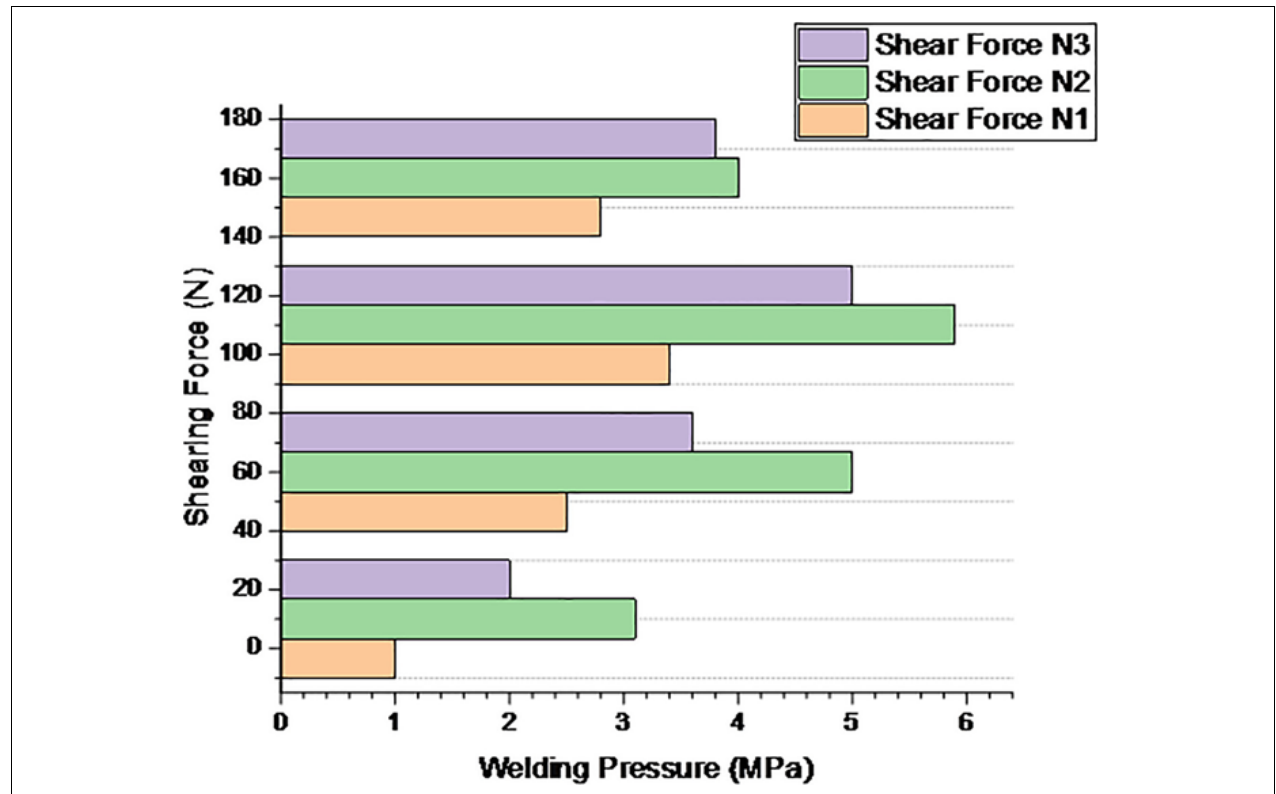
FIGURE 6 | Relation between welding time and welding pressure for various shearing